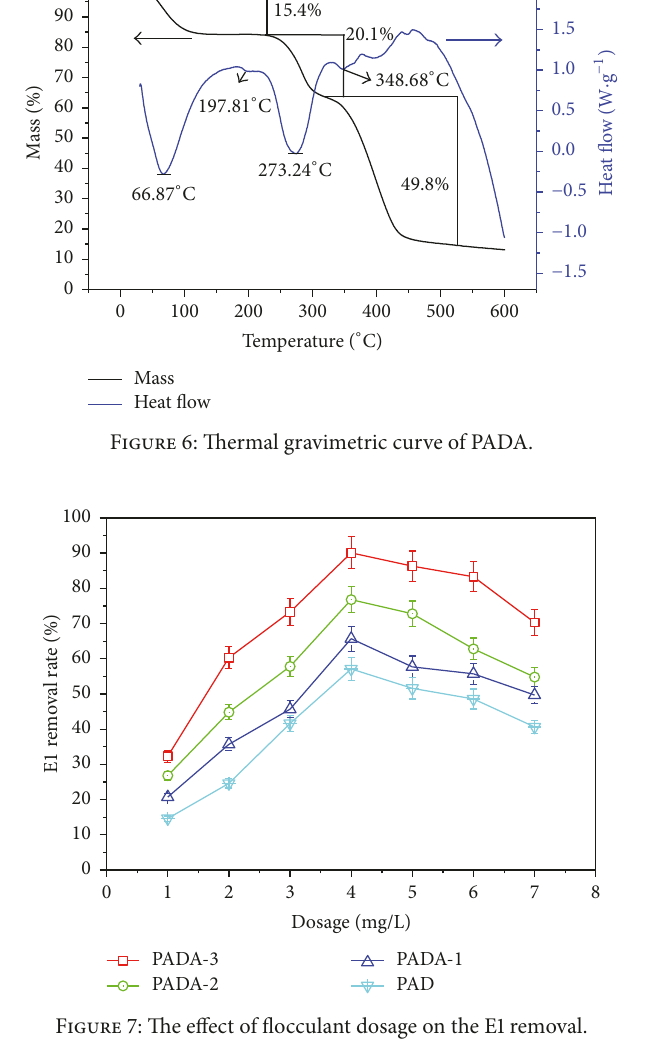
22.69 × 10 −4 s −1 ) reached the largest among the flocculants,